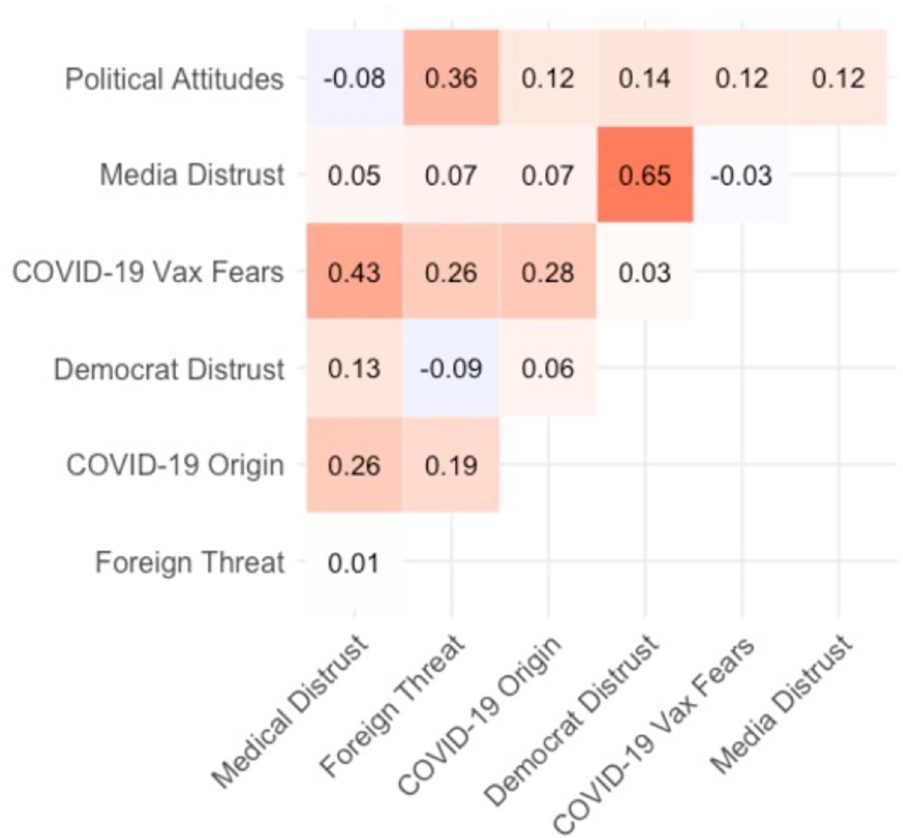
Fig 4. Pairwise partial correlations between beliefs based on prewave survey. Higher values on the Political Attitudes scale implies more conservative political stance. The shading on each cell represents correlation value (darker red = stronger positive; darker purple = stronger